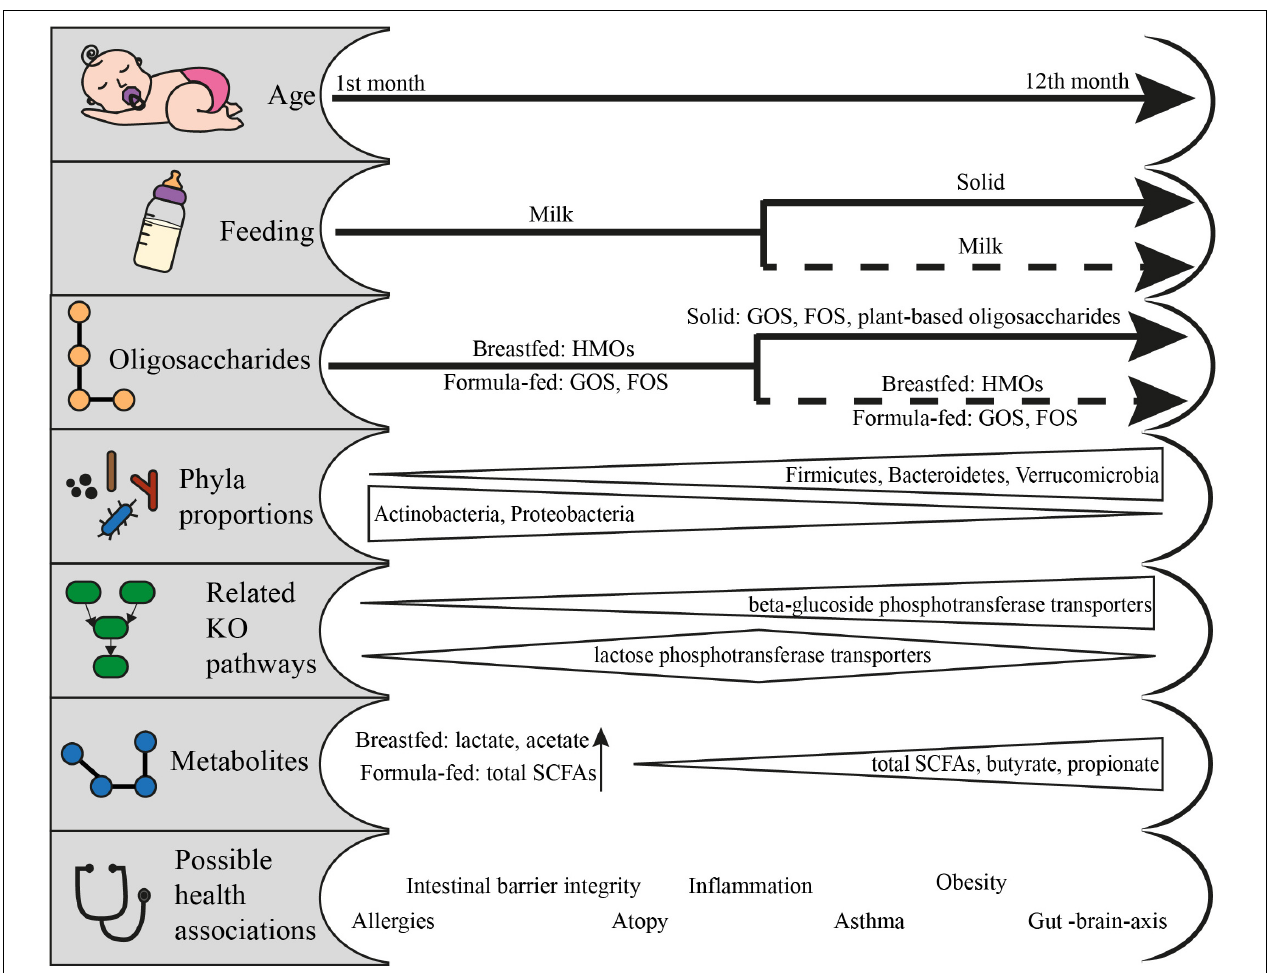
FIGURE 2 | From feeding to health outcomes in the first year of life: feeding patterns and the respective available oligosaccharides, the change in phyla proportions, the KO pathways related to the utilization of fed oligosaccharides, the metabolites produced and the possible health associations. Data adapted from Schwiertz et al. (2010), Koenig et al. (2011), van der Aa et al. (2011), Bäckhed et al. (2015), Huang et al. (2017), Cait et al. (2019), Roduit et al. (2019), Venegas et al. (2019), and Differding et al.